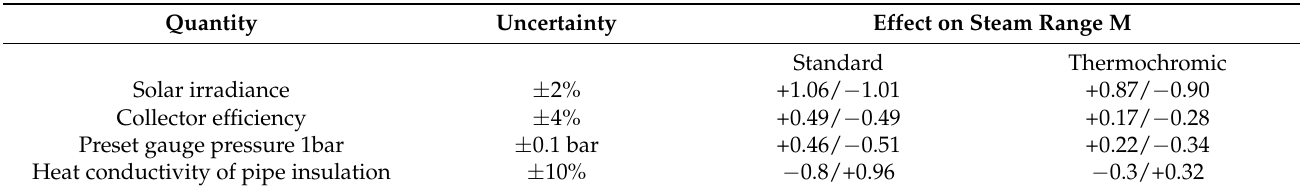
Table 3. Uncertainties of material properties and boundary conditions and their effect on the simulated steam range, based on data set 08 − 16.